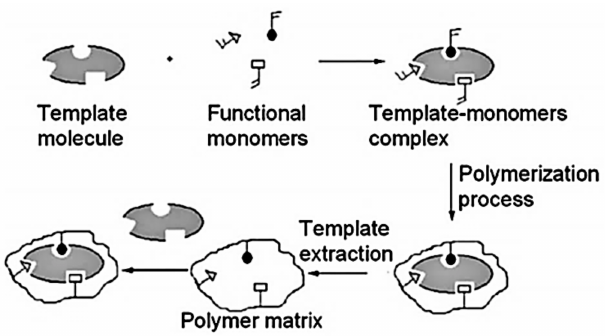
Figure 10. General scheme of preparation and recognition mechanism of MIPs [96]. Reproduced with permission of Elsevier.